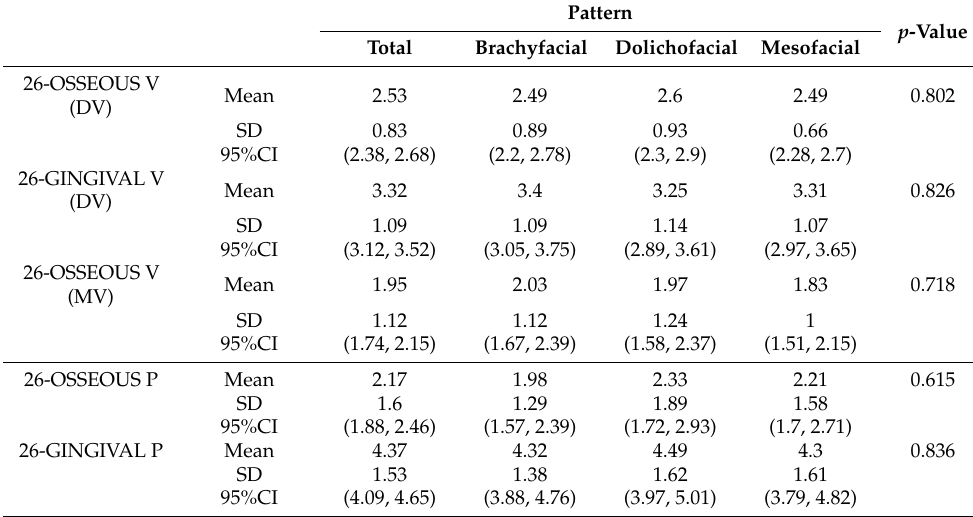
Table 3. Linear measurements corresponding to upper left molars in the different vertical facial